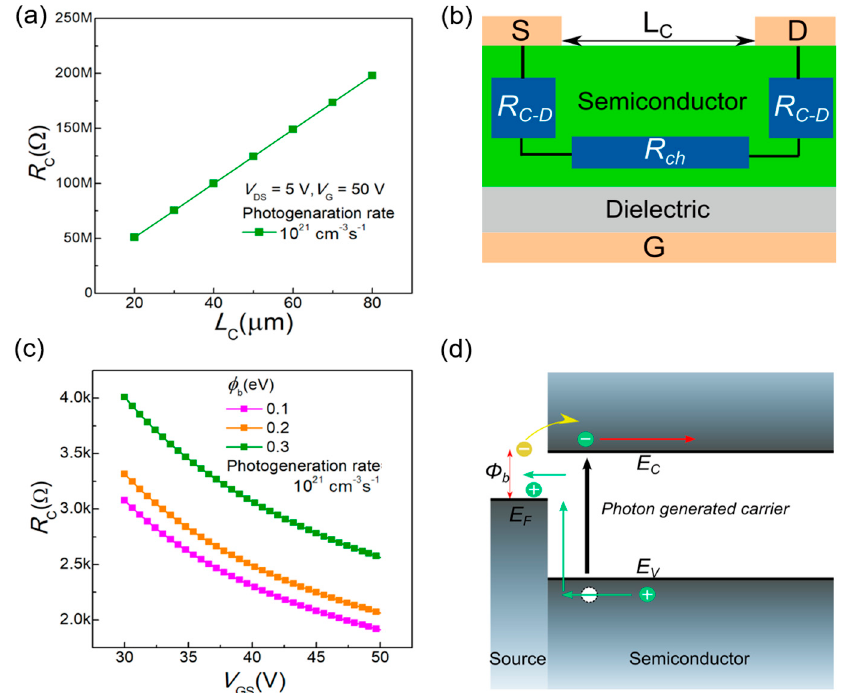
Figure 3. ( a , b ) Contact resistance extracted using the TLM method; ( c ) Contact resistance of TFTs with various injection barriers, plotted as a function of gate bias and photogeneration rate; ( d ) illustration of the energy diagram for the charge transport in the contact region. Note that green denotes photogenerated charges, while yellow denotes charges injected from electrodes.